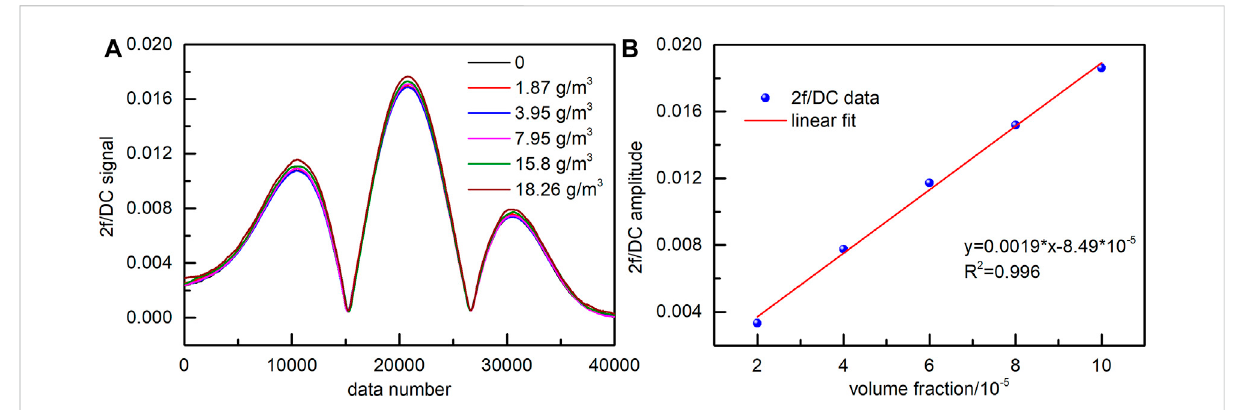
2f peak-to-peak error of NO before correction Corrected 2f peak-to-peak error of NO Concentration error of NO before correction Corrected concentration error of NO 2f/DC peak error of NO Concentration error of NO caused by